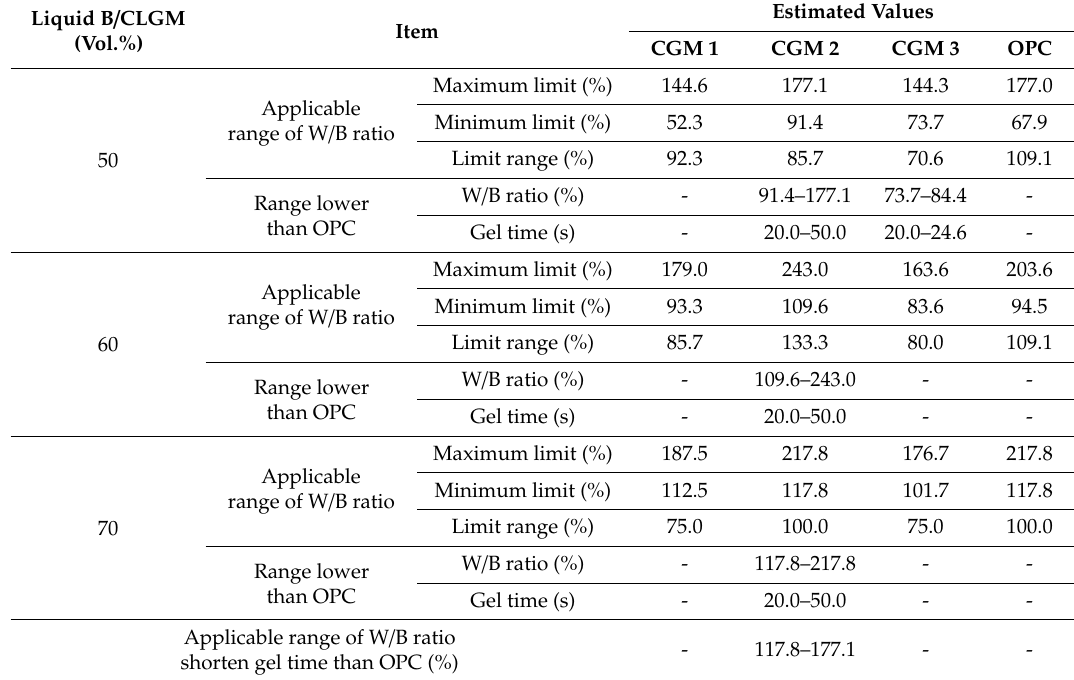
Table 6. Estimated values of W / B ratio and gel time with volume replacement of Liquid